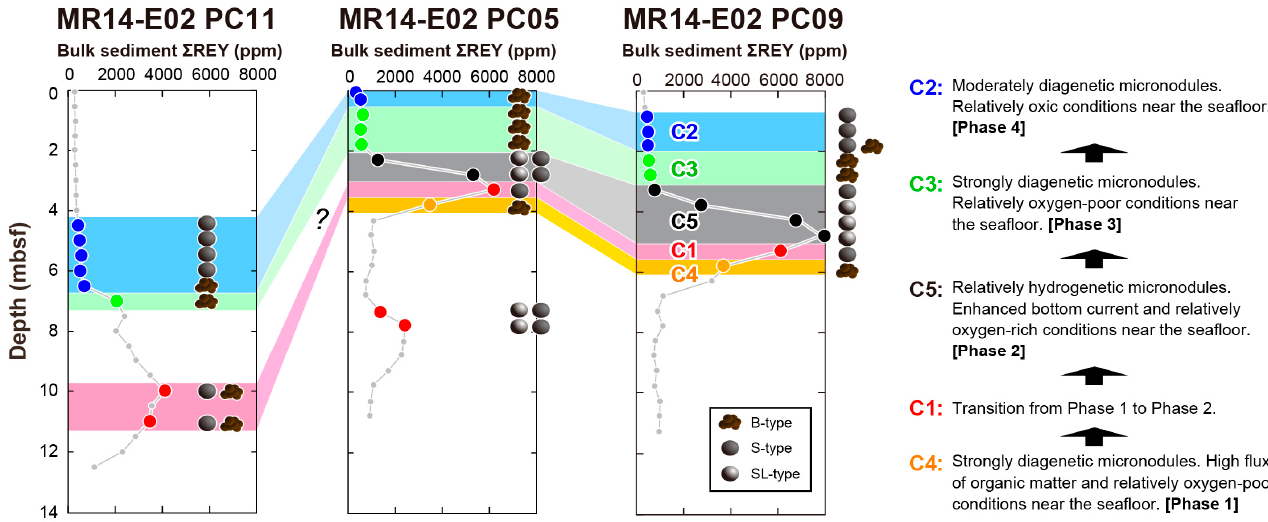
Figure 9. Summarized stratigraphic correlation of the clustering ( K = 5) and surficial textures of the Fe–Mn micronodules together with the environmental conditions inferred for the sedimentation layers characterized by each cluster.